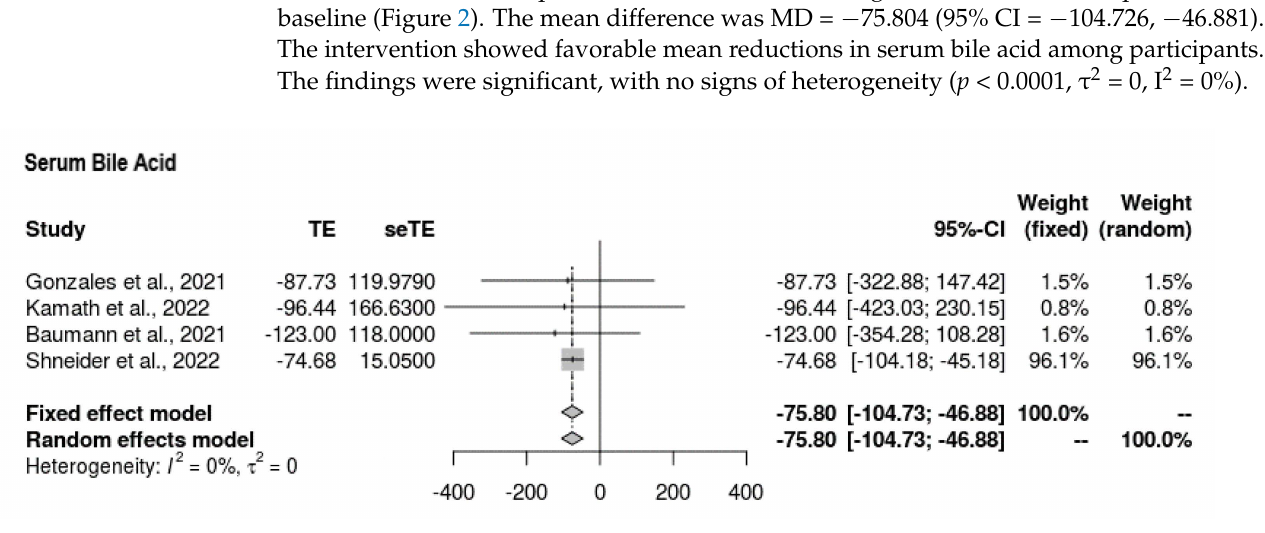
Figure 2. Forest plot depicting serum bile acid outcomes [19–22].